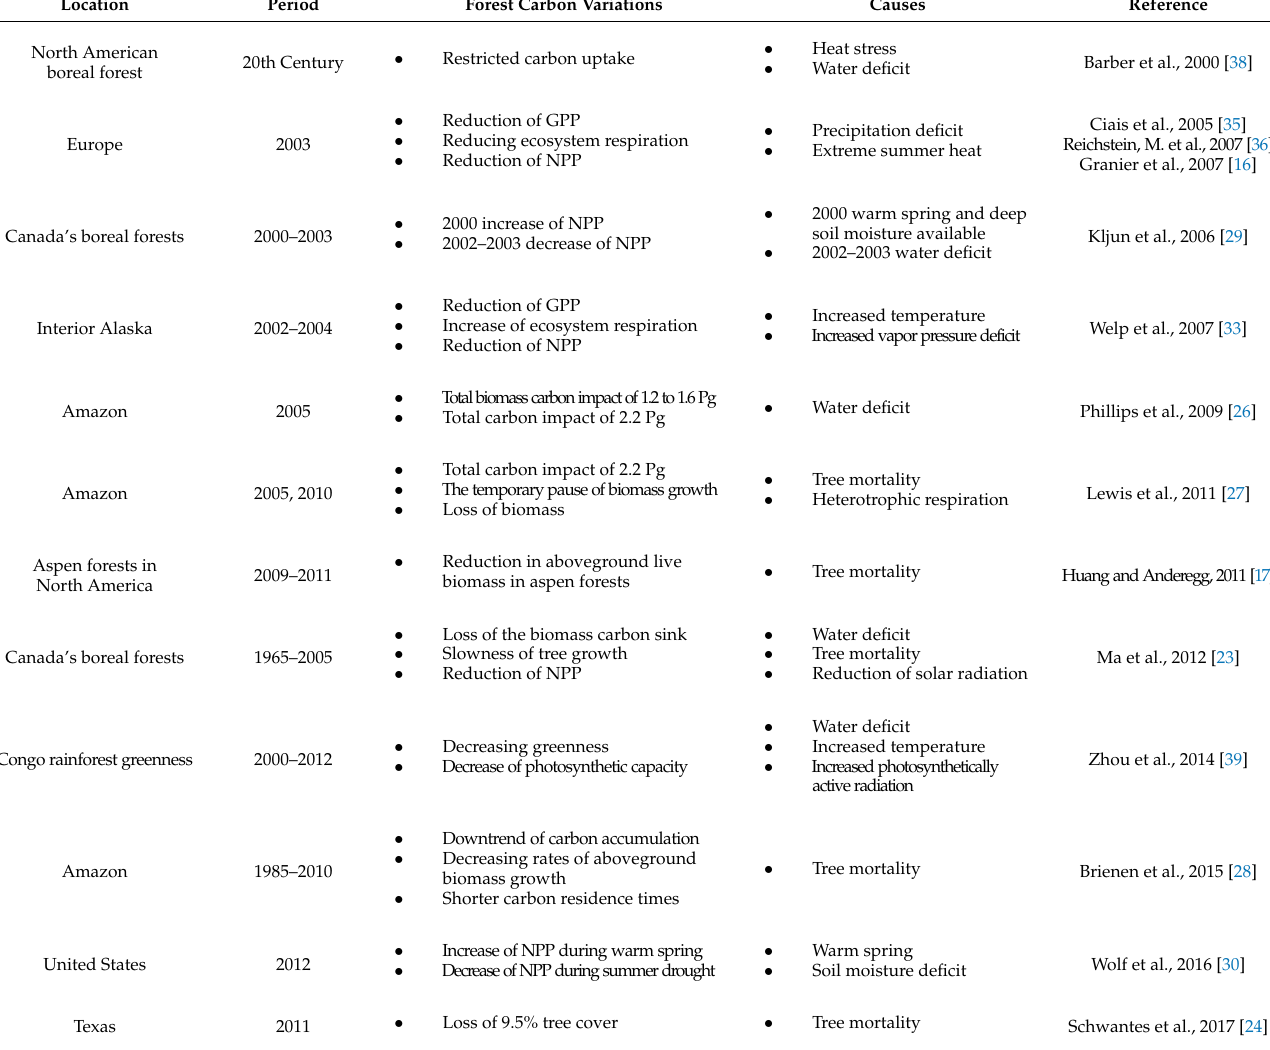
Table 1. Summary of forest carbon cycle responses to drought events in recent two